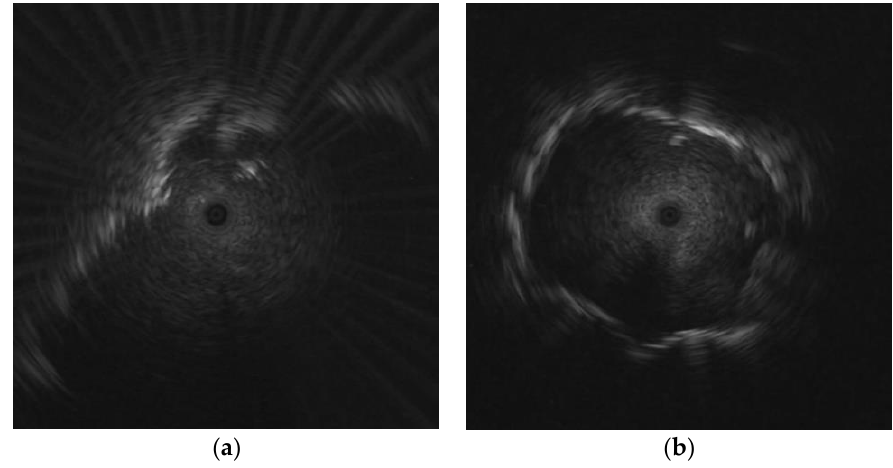
Figure 17. Two out of three models misclassified a lesion, but the proposed framework can classify correctly: ( a ) benign lesion was misclassified as malignant in radiomics feature and patient data- based model and multi-patch-based model; ( b ) benign lesion was misclassified as malignant in single image-based model and multi-patch-based model.